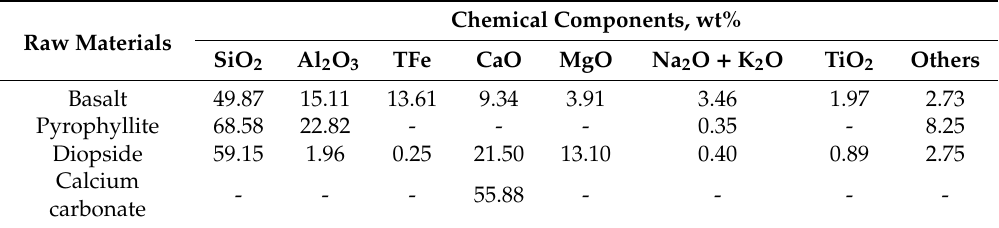
Table 1. Chemical composition of the raw